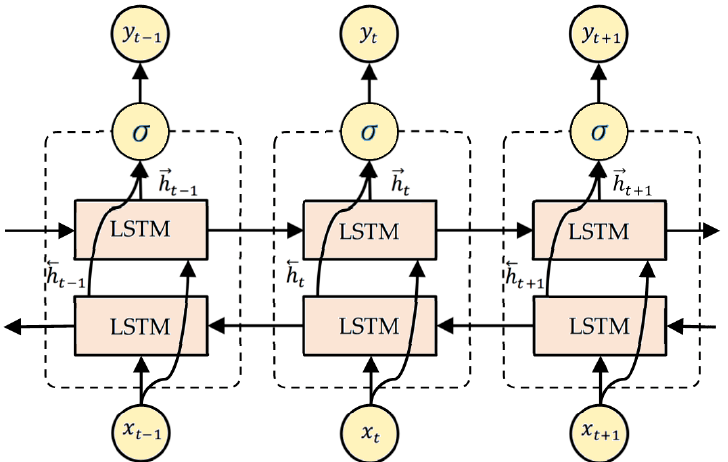
Figure 3. A Bidirectional LSTM (BiLSTM) with three unfolded consecutive